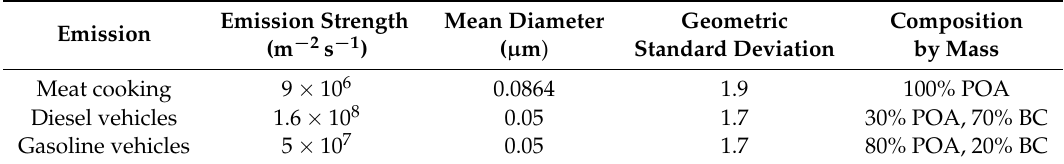
Table 2. Size distribution and composition of aerosol emissions prescribed in simulations. BC stands for black carbon and POA stands for primary organic carbon.